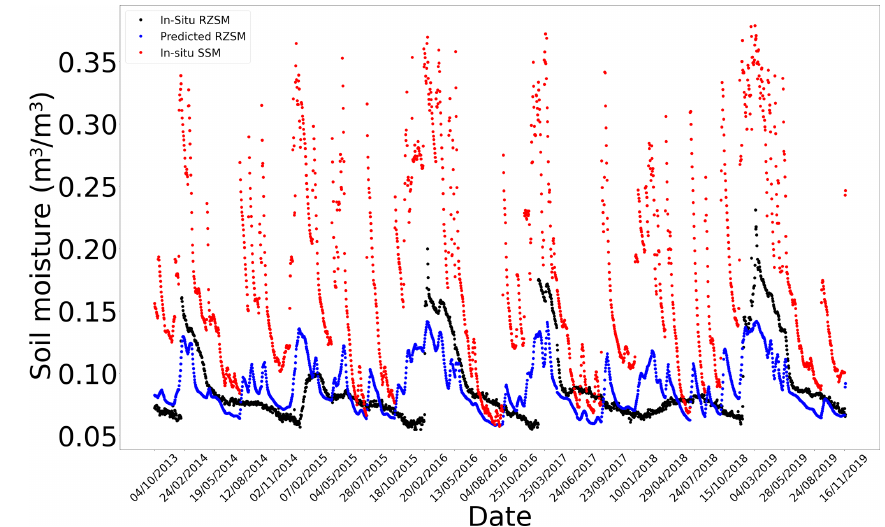
Figure E7. In situ SSM, in situ RZSM, and predicted RZSM series at station Nephi (SCAN) with model ANN_SSM.